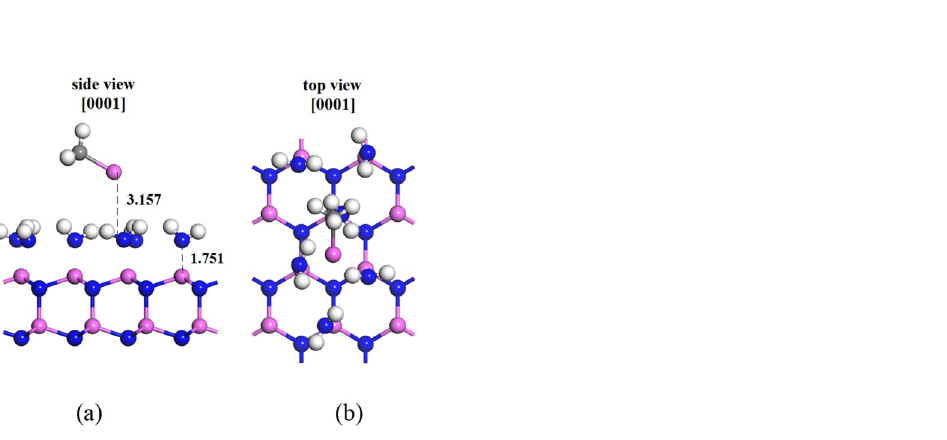
Figure 5. ( a ) Side-view and ( b ) Top-view of (2 × 2) slab model of reconstructed AlN (0001) surface, where pink, blue and white spheres denote aluminum, nitrogen and hydrogen atoms, respectively. The digital signs show the distance from AlCH 3 to the NH 2 coverage layers and the distance from the NH 2 coverage layers to the AlN (0001) surface, the unit is